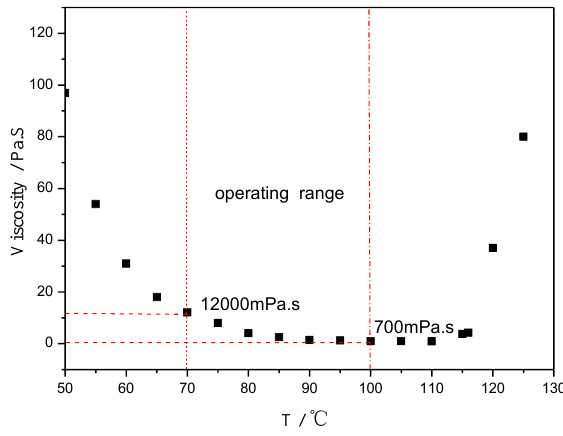
Figure 2. Viscosity vs. temperature of AGMP3600, a rosin-sourced epoxy resin system.